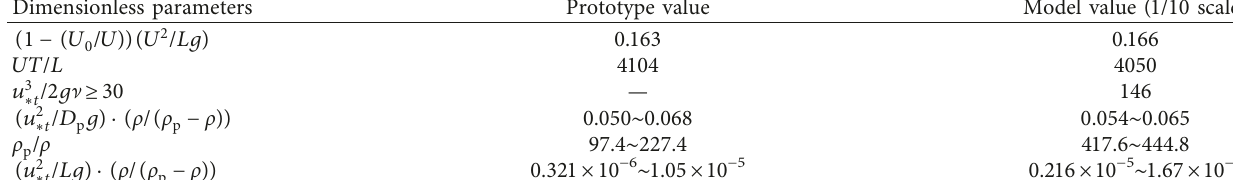
Table 4: Similarity parameters of prototype and scale model.